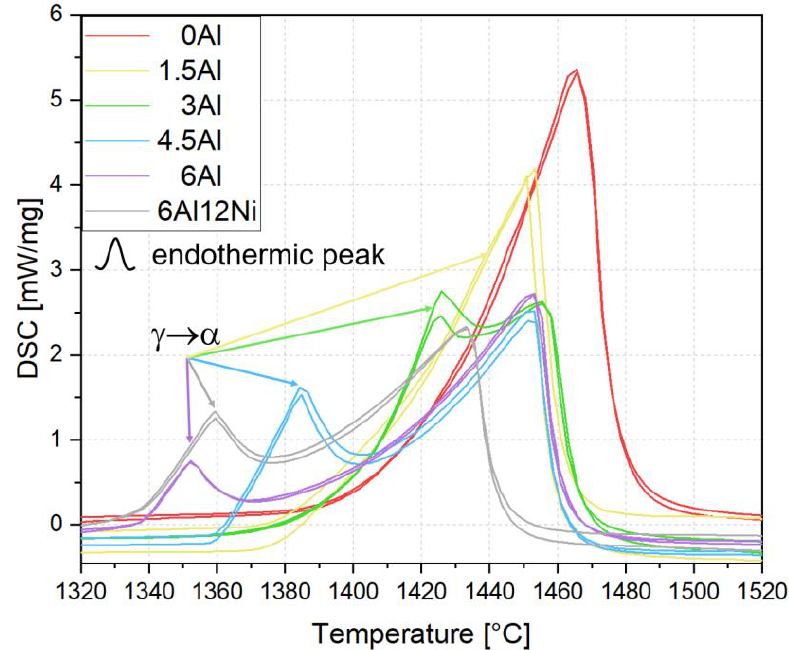
Figure 3. DSC results during heating up to 1520 °C for the interpretation of the sequence of transformations during solidification.